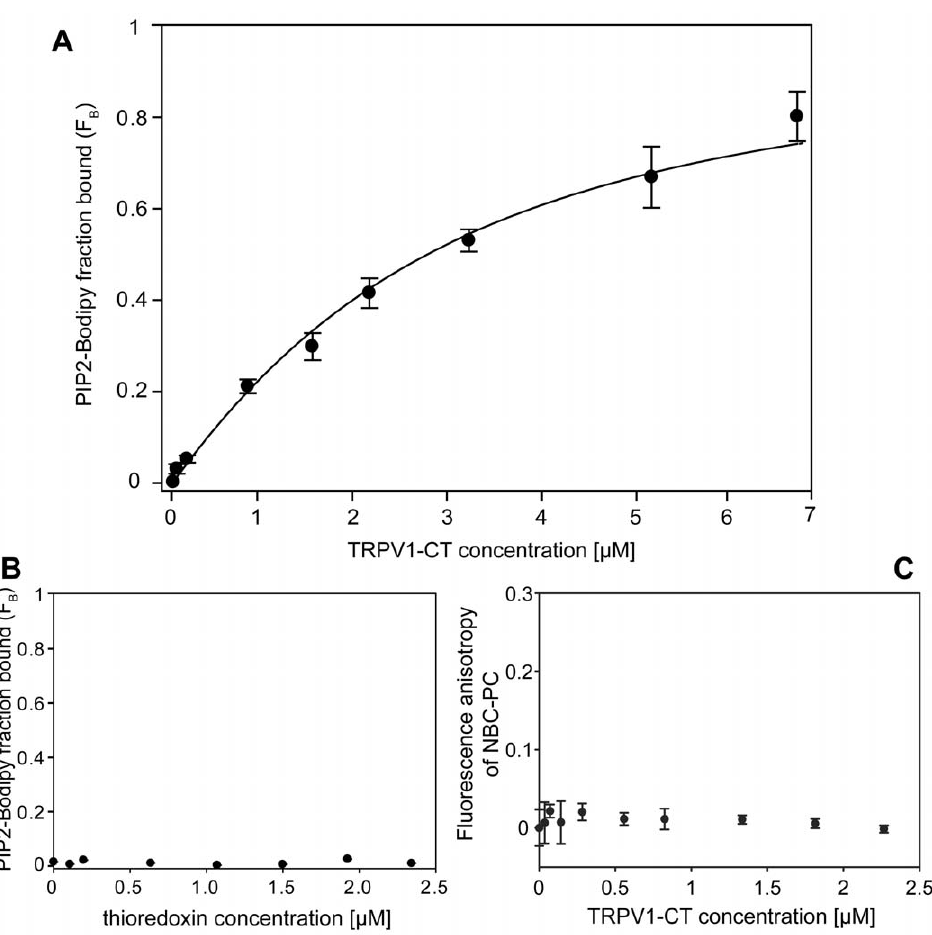
Figure 1. PIP2 binds to the C-terminal distal region of TRPV1. A. Fluorescence anisotropy measurements of interaction between fluorescently labeled phosphatidyl inositol-4, 5-bisphosphate (PIP2-Bodipy) and the distal region of TRPV1 (amino acids 712–838) fusion protein. PIP2-Bodipy (10 nM) was titrated with TRPV1-CT fusion protein WT and the bound fraction (FB) was calculated according to Equation 1 as described in Material and Methods. Binding isotherm and the equilibrium dissociation constant KD (3.48 + / 2 0.93 m M) was determined by fitting the data to the Equation 2 as described in Material and Methods. B. Fluorescence anisotropy measurements of interaction between PIP2-Bodipy and thioredoxin. PIP2-Bodipy (10 nM) was titrated with thioredoxin and the bound fraction (FB) of PIP2 Bodipy was calculated as above. C. Steady-state fluorescence anisotropy measurement of interaction between fluorescently labeled phosphatidyl choline (NBD–PC) and TRPV1-CT. NBD-PC (10 nM) was titrated with indicated concentrations of TRPV1-CT fluorescence anisotropy was recorded. Values are expressed as the mean 6 standard deviation (SD) measured from at least from six independent experiments.